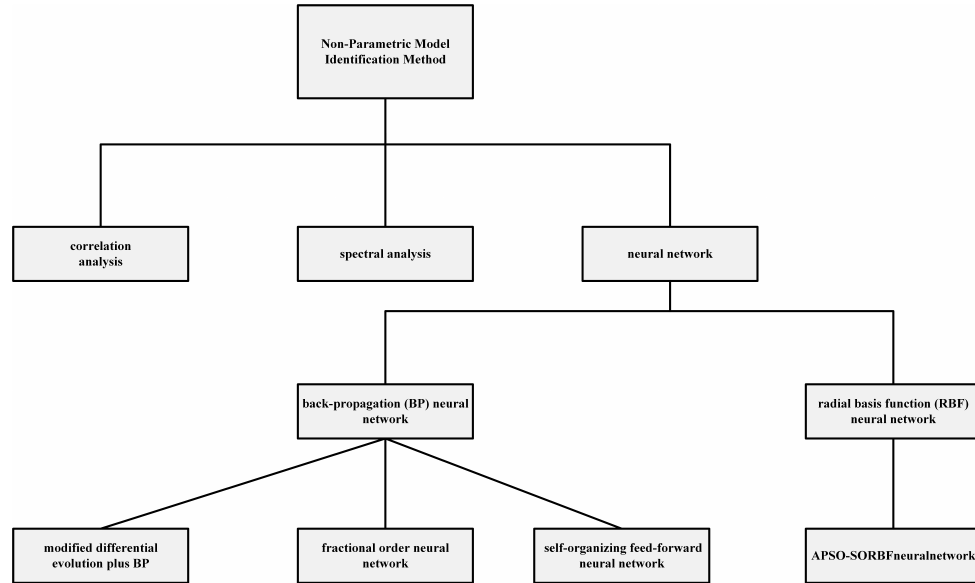
Figure 3. Overview of Non-Parametric Model Identification